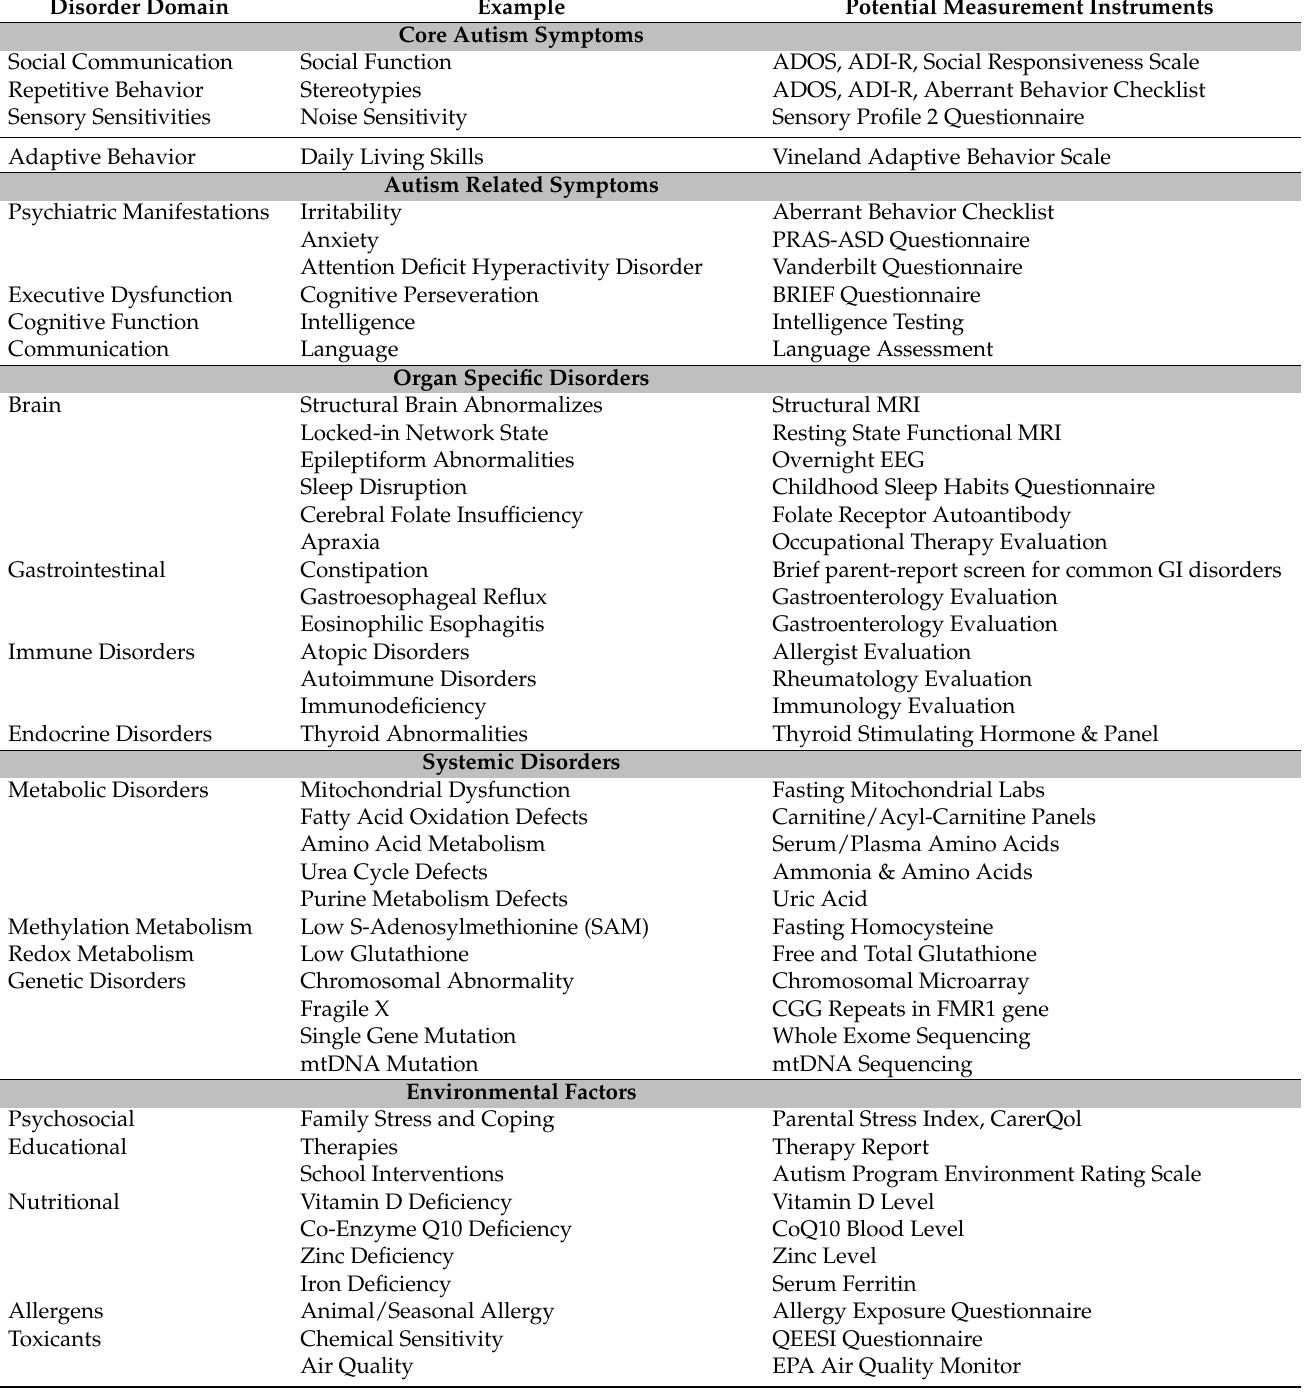
Table 2. Measurement tools used to assess the severity of common disorders and their associated symptoms in children with Autism Spectrum